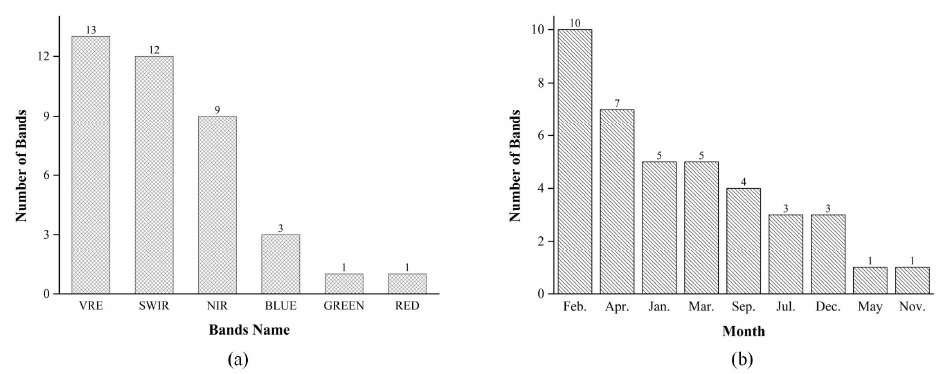
Figure 10. ( a ) The number of different bands in Scheme VI. ( b ) The number of different months in Scheme VI. Table 4. Accuracy of optimal multi-temporal and mono-temporal